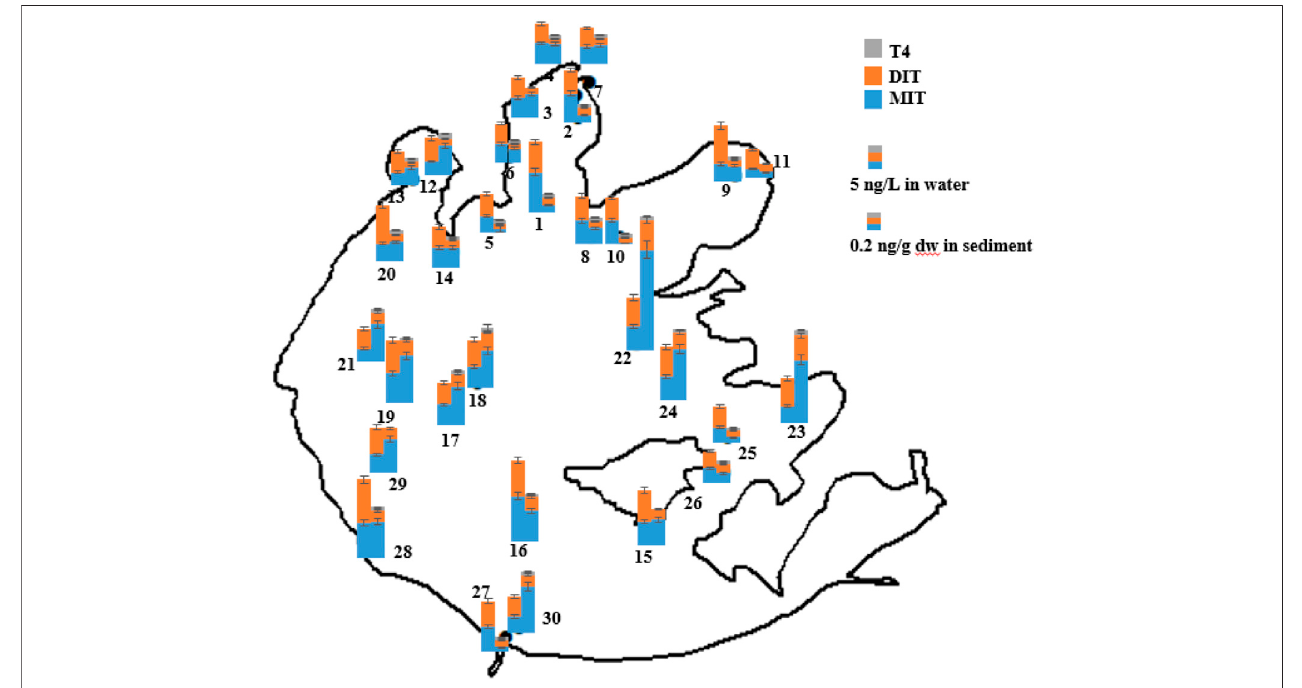
FIGURE 2 | Occurrence and distribution of the thyroid hormones detected in 30 pairs of water (left) and sediment samples (right) from Taihu Lake.